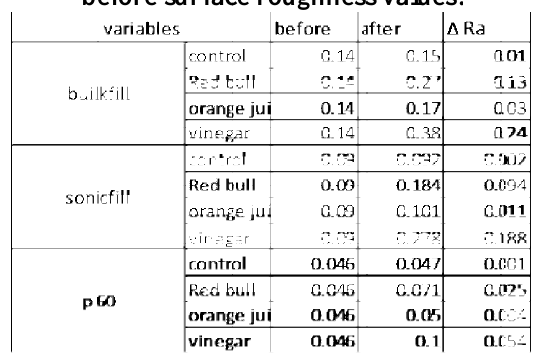
of composite is related to the size of filler parti particles exhibited higher surface roughness. effect of silane surface treatment on the fillers surface degradation may be happened when the filler and